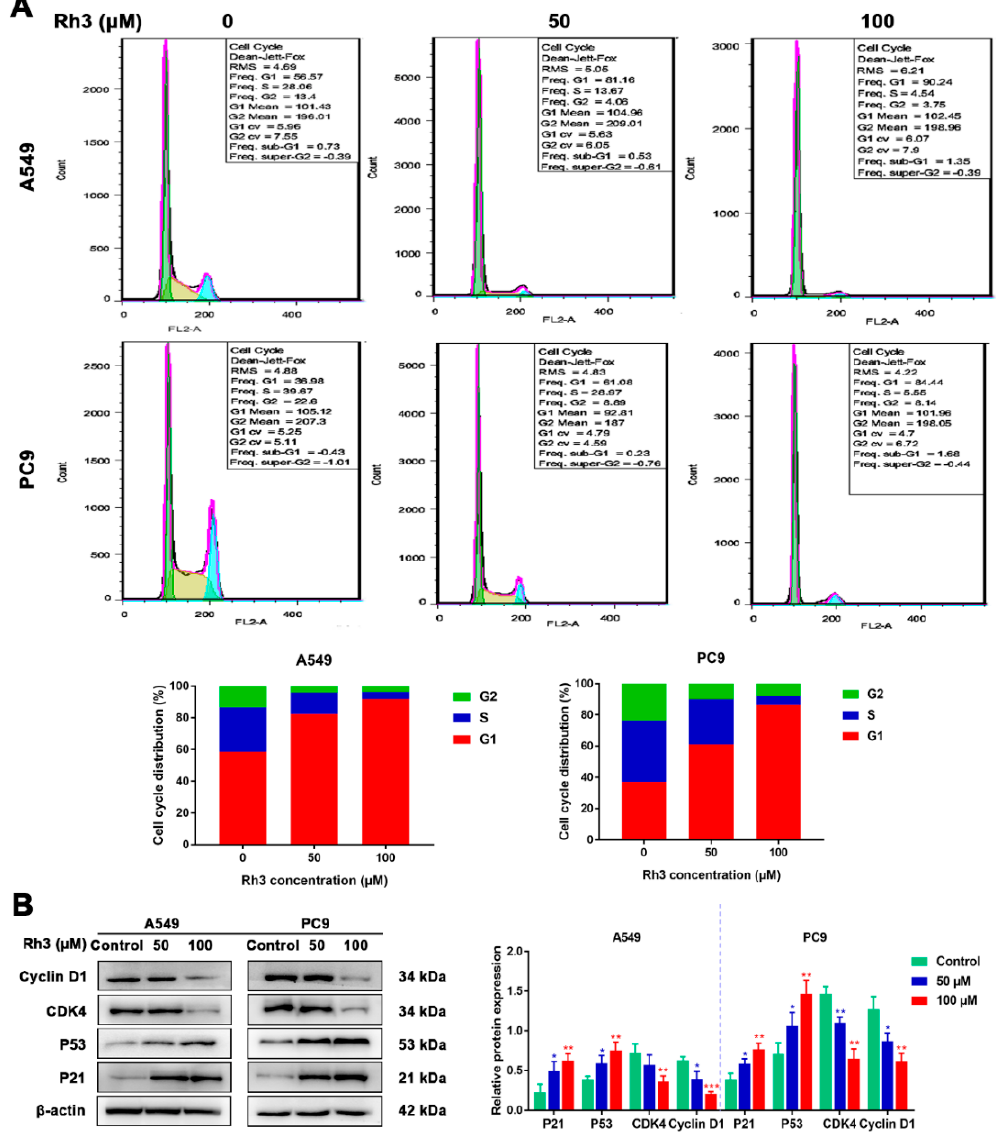
Figure 2. Ginsenoside Rh3 induces G1 cell cycle arrest in human lung cancer cells. ( A ) Rh3 (50 and 100 μ M) induced G1 cell cycle arrest. Lung cancer cells were treated with Rh3 for 24 h and analyzed by flow cytometry. ( B ) Western blotting shows the levels of G1-related proteins of lung cancers after Rh3 (50 and 100 μ M) treatment. β -actin was used as an endogenous reference. The histogram represents the statistical analysis of the relative expression of G1-related proteins. * p < 0.05, ** p < 0.01, *** p < 0.001 compared with the control.